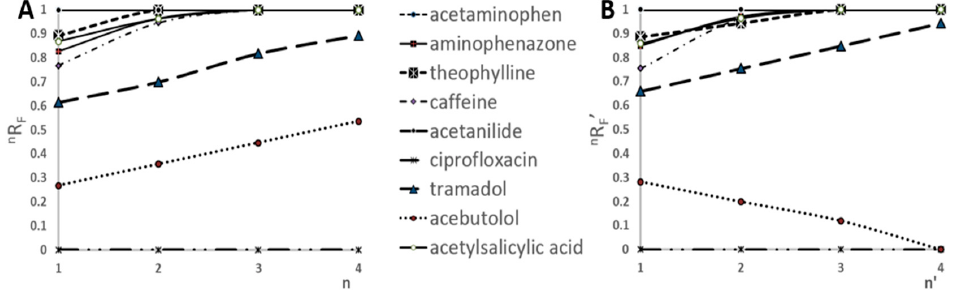
Figure 1. ( A ) n R F of solutes vs. the number of developments. ( B ) n R F ’ of solutes vs. the number